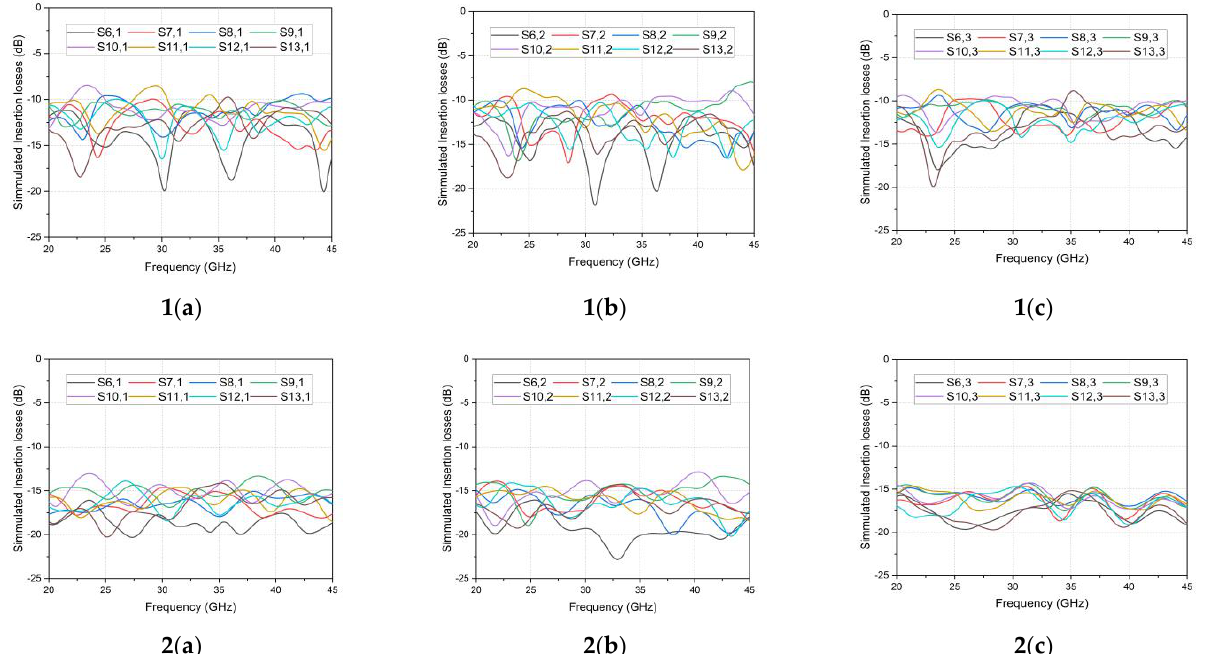
Figure 5. Simulated insertion losses of ( 1 ) SICL- and ( 2 ) MSL-based RL at array ports when ( a ) beam port 1 is excited, ( b ) beam port 2 is excited, and ( c ) beam port 3 is excited.